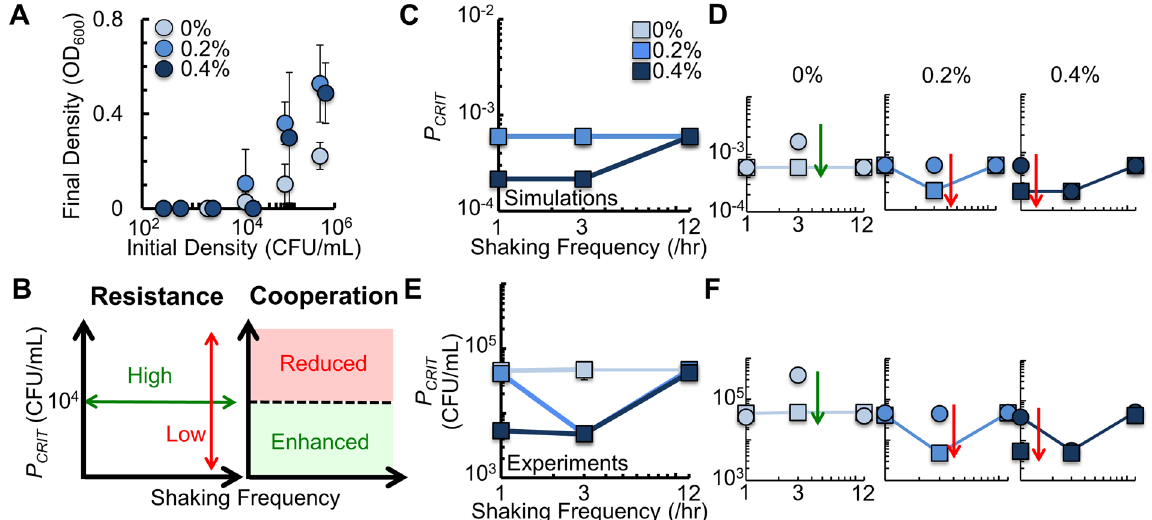
Figure 5. Increasing access to AHL perturbs the ability of bacteria to resist periodic spatial disturbance. ( A ) P CRIT of engineered bacteria grown in different agar densities but in the absence of shaking. Average P CRIT observed in all three agar densities was 4.84 × 10 4 ± 1.91 × 10 4 CFU/mL ( p = 0.12, two-tailed t-test). Two-tailed t-tests for each P CRIT in Supplementary Tables S1 and S2. SD from twelve measurements, consisting of at least three biological replicates per agar density. ( B ) Measuring resistance and cooperation. Left: In an undisturbed environment, P CRIT was ~10 4 CFU/mL. If the bacteria were resistant to disturbance, P CRIT would remain at this density (green arrow). Changes in P CRIT show a decrease in resistance (red arrow). Right: Cooperation is enhanced (green) or reduced (red) if P CRIT is reduced or increased from ~10 4 CFU/mL, respectively. ( C ) Simulation results (Equations (1–3)) showing P CRIT with decreased k d . For simplicity, we show the three shaking frequencies measured experimentally. For a high-resolution simulation, consult Supplementary Fig. S5. ( D ) Individual simulations with decreased k d . Squares indicate simulation data performed with decreased k d . Circles indicate simulation data re-plotted from Fig. 4D. For panels (D,F), green arrows indicate increased resistance. Red arrows indicated reduced resistance. Direction of arrow indicates perturbation to P CRIT . ( E ) P CRIT of engineered bacteria grown in medium with pH 7.0. Two-tailed t-tests for each P CRIT in Supplementary Tables S1 and S2, including comparisons between P CRIT in medium with pH 7.4 and pH 7.0. SD from a minimum of three biological replicates. ( F ) Individual experiments for each agar density. Squares indicate P CRIT from